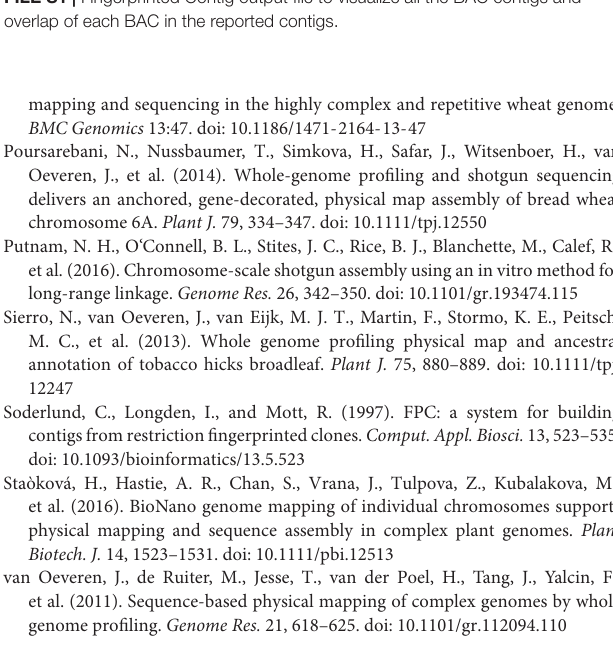
TABLE S1 | Unique sequence tags identified by sequencing ends of restriction fragments of 295,680 BAC clones. TABLE S2 | BAC clones corresponding to the unique sequence tags identified by sequencing ends of restriction fragments of 295,680 BAC clones. TABLE S3 | Number of BAC clones in each contig built based on the sequence similarities of unique sequence tags. TABLE S4 | Distribution of BAC clones in contigs built based on the sequence similarities of unique sequence